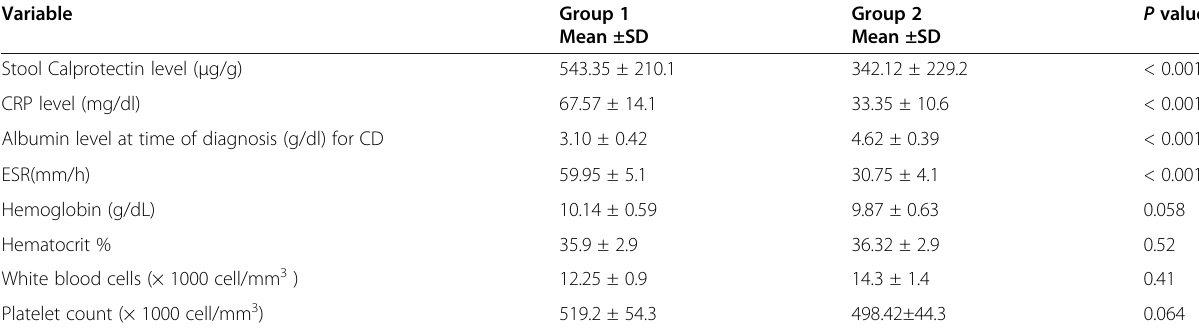
Table 2 Comparison between both groups as regard laboratory data Variable